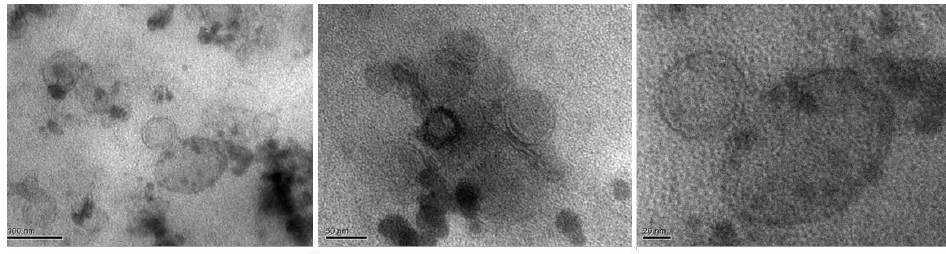
Figure 6. P. fluorescens SBW25 Wrinkly Spreader biofilms contain membrane vesicles. Shown here are three transmission electron microscopy (TEM) images of increasing magnification of membrane vesicles (MVs) isolated from three-day-old Wrinkly Spreader biofilms. The scale bars indicate 100 nm, 50 nm, and 20 nm ( left to right ).